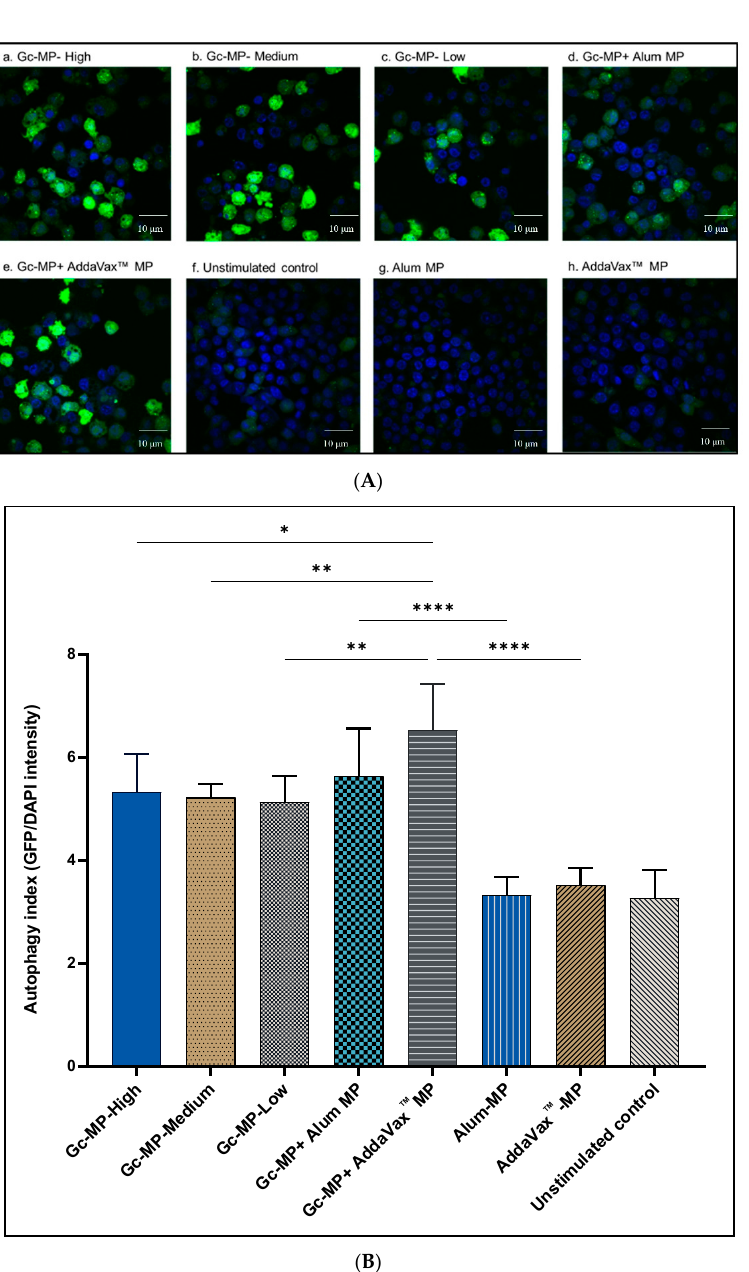
Figure 1. Autophagy induction in GFP-LC3-RAW264.7 macrophages induced with gonococci vaccine microparticles (Gc-MP) with or without adjuvant MP. Macrophages were adjusted to 1 × 10 6 cells/mL and induced with various doses of vaccine microparticles for 18 h. Gonorrhea vaccine microparticles Gc-MP-High 100 µg/mL, Gc-MP-Medium 50 µg/mL, Gc-MP-Low 25 µg/mL, Gc-MP with Alum microparticles (Gc-MP+ Alum MP) 50 µg/mL of each, Gc-MP with AddaVax™ microparticles (Gc-MP+ AddaVax™ MP) 50 µg/mL of each. Unstimulated control, Alum MP, and AddaVax™ MP alone were used. ( A ): Representative confocal microscopy images of autophagy induction in GFP-LC3- RAW264.7 macrophages exposed to different treatments. Green fluorescence protein-conjugated light chain 3 (GFP-LC3 puncta) indicates active autophagy and DAPI (blue) reflects nucleus staining. ( B ): Autophagy index quantitation was calculated by dividing GFP intensity over DAPI intensity using systemic image analysis of at least 6 different images for each treatment. All treatments were repeated six times. Data are expressed as mean ± SD, Brown-Forsythe, and Welch ANOVA test. * p < 0.05 significant, ** p < 0.01 very significant, **** p < 0.001 extremely